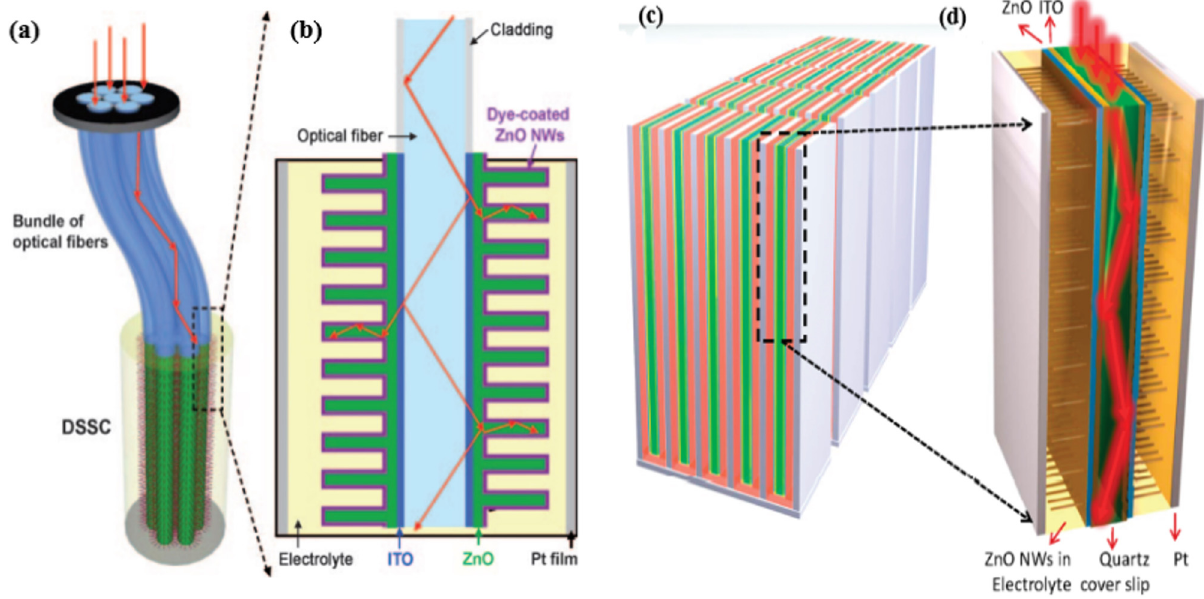
Figure 23: Design and principle of a 3 - D dye - sensitized solar cells ( DSSC ) . The cross section of the fi ber can be cylindrical or rectangular. ( a ) The 3 - D DSSC is composed of optical fi bers and ZnO NWs are grown vertically on the fi ber surface. The top segment of the bundled optical fi bers utilizes conventional optical fi bers and allows for remote transmission of light. The bottom segment consists of the 3 - D DSSC for solar power generation at a remote/concealed location. ( b ) Detailed structure of the 3 - D DSSC. Reproduced with permission from Wiley - VCH [ 421 ] . ( c ) Schematic architecture of a large - scale 3 - D DSSC. The waveguide - NW 3 - D unit SCs are plugged into the counter electrode housing and then sealed and fully packaged. ( d ) Detailed structure of a unit waveguide - NW 3 - D DSSC. Reproduced with permission from American Chemical Society [ 422 ]